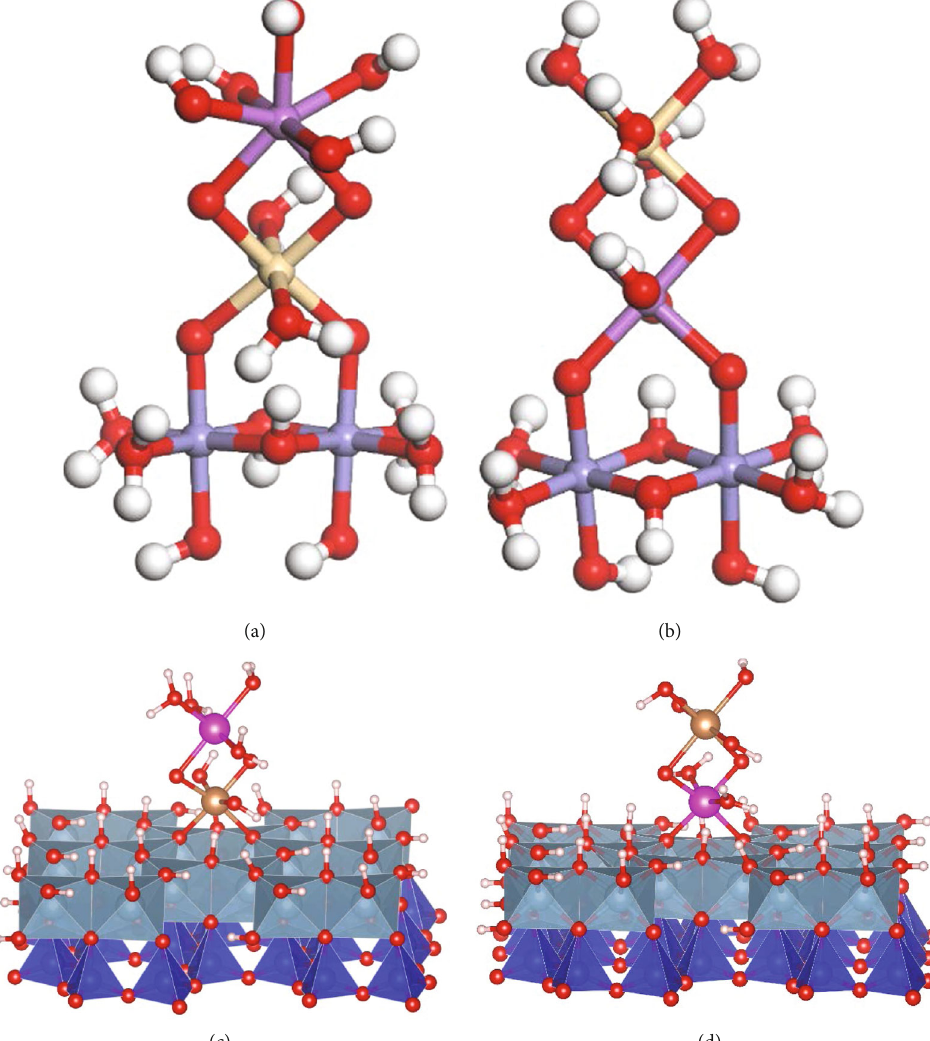
Figure 8: The structures of two possible ternary complexes on (a, b) goethite and (c, d)